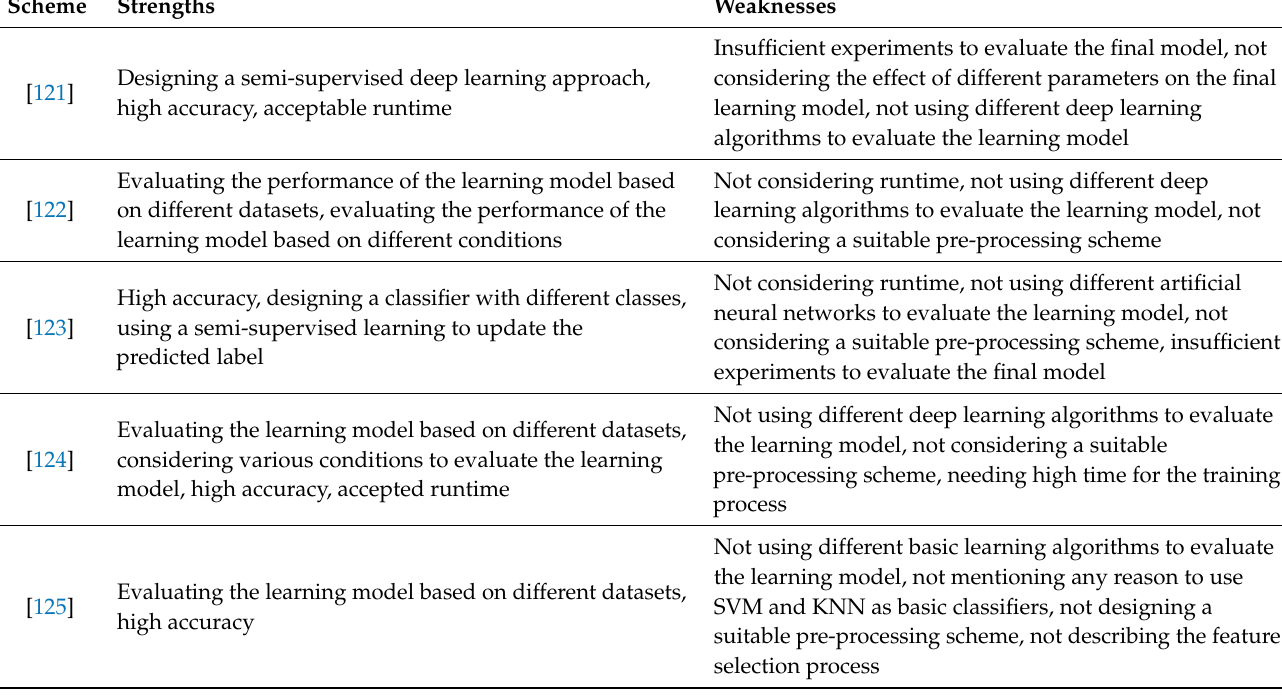
Table 13. The most important strengths and weaknesses of semi-supervised learning-based